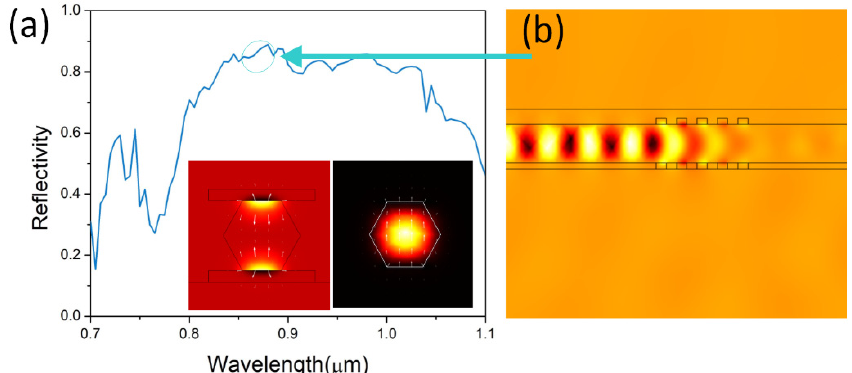
Figure 2. Reflective properties of double gratings. ( a ) Reflectivity spectrum of the nanowire with double gratings. ( b ) Profile of H z of the propagating mode. Insets are electromagnetic energy density profiles of mode HE 11 a for the nanowire sandwiched in the silver grating teeth and in the air. The diameter of the nanowire is 250 nm.